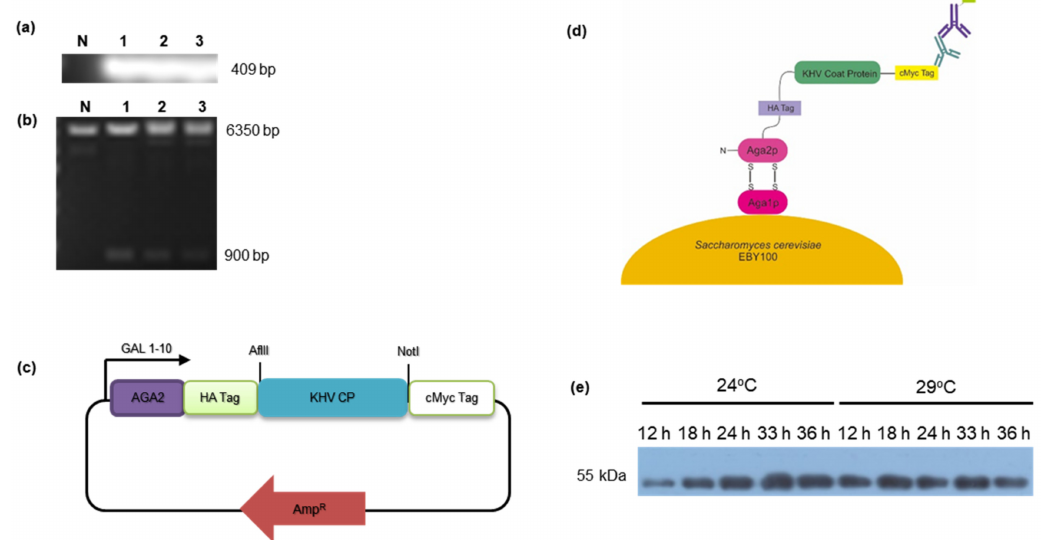
Figure 1. ( a ) Targeted PCR detection of the KHV capsid subunit 2 gene with a size of approximately 400 bp. Lane N is the no-template control, and lanes 1–3 are the amplified KHV fragments of the coat protein gene. ( b ) Digested fragments of the pCTCON-KHV gene with sizes of 6350 bp and 900 bp (lanes 1–3) were digested using Sac I. pCTCON-RSIV. ( c ) Schematic diagram of the yeast surface display system. KHV coat protein expressed with multiple tags (HA and c-Myc) and C-terminus glycoprotein (Aga2p) that covalently bind with Aga1p on the surface membrane. The c-Myc tag was used to detect antigen expression. ( d ) Schematic diagram of the pCTCON-KHV plasmid containing KHV coat protein (CP) (Genebank Acc. Number: QAU54957.1 with N286Q modification) used for an antigen-expressed yeast surface display. ( e ) Yeast surface display of KHV CP expression optimization assay at 24 ◦ C and 29 ◦ C and 12–36 h induction time intervals, detected using anti-cMyc (9E10) and anti-mouse-HRP